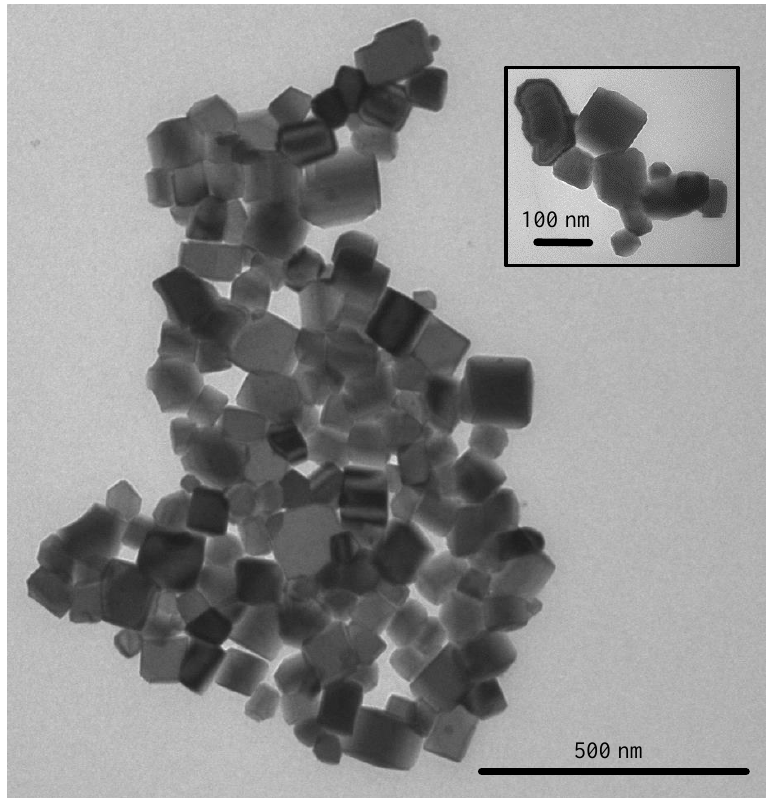
Figure 6. TEM image of Pb 1− х La х Fe 12− x Zn x O 19 nanoparticles ( x = 0.1) synthesized by gel processing.